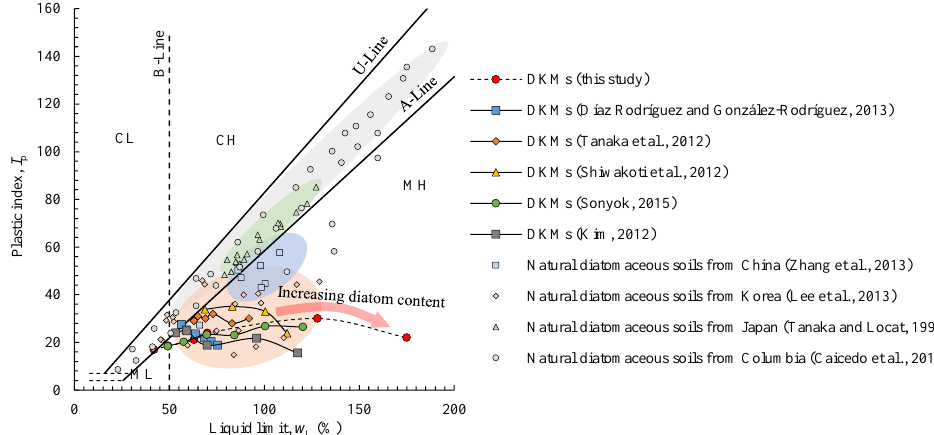
Figure 7. Casagrande plasticity chart for diatomaceous soil (DS). Data sources: DKMs [6,12,31,32,34], Natural diatomaceous soils [2 – 5].